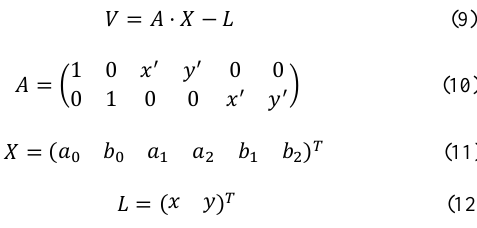
Figure 3. The homogenous points on the right image are matched with those on the left image The origin of the image coordinate frame is located on the top left corner for each image. For many strips of images, the stitching processing could be implemented from one side to the other side. If the homogenous points are redundant for Equations (1) and (2), the least squares model is used and showed